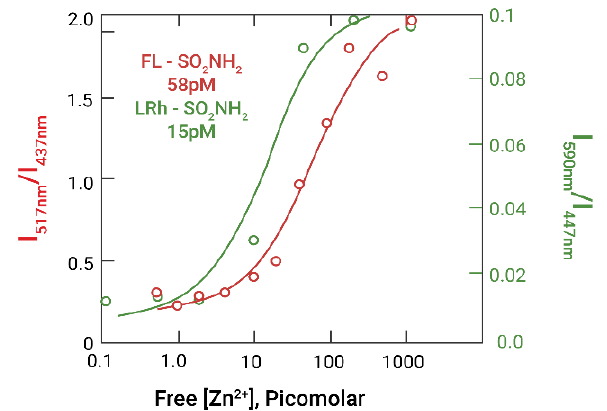
Figure 3. Zinc-dependent bioluminescence intensity ratios and best fit binding isotherms of NanoLuc-apoCA with Fluorescein sulfonamide (I 517 nm /I 437 nm , ●–●) (red) and Lissamine Rhodamine sulfonamide (I 590 nm /I 447 nm , O – O) (green).